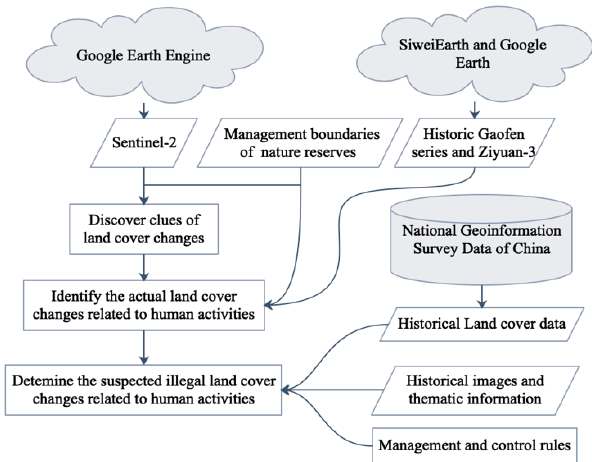
Figure 1. Technical framework of suspected illegal land cover change